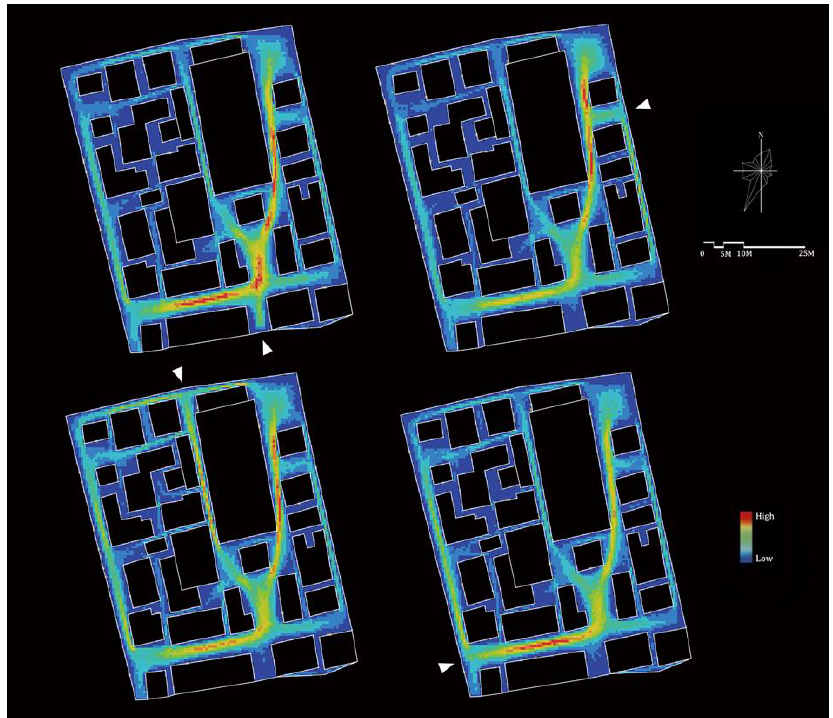
Figure 7. Pedestrian flow simulation on VGA of Baoshan historical block in Figure 5 (The red and the blue denotes the high and low tourist intensity, respectively.).